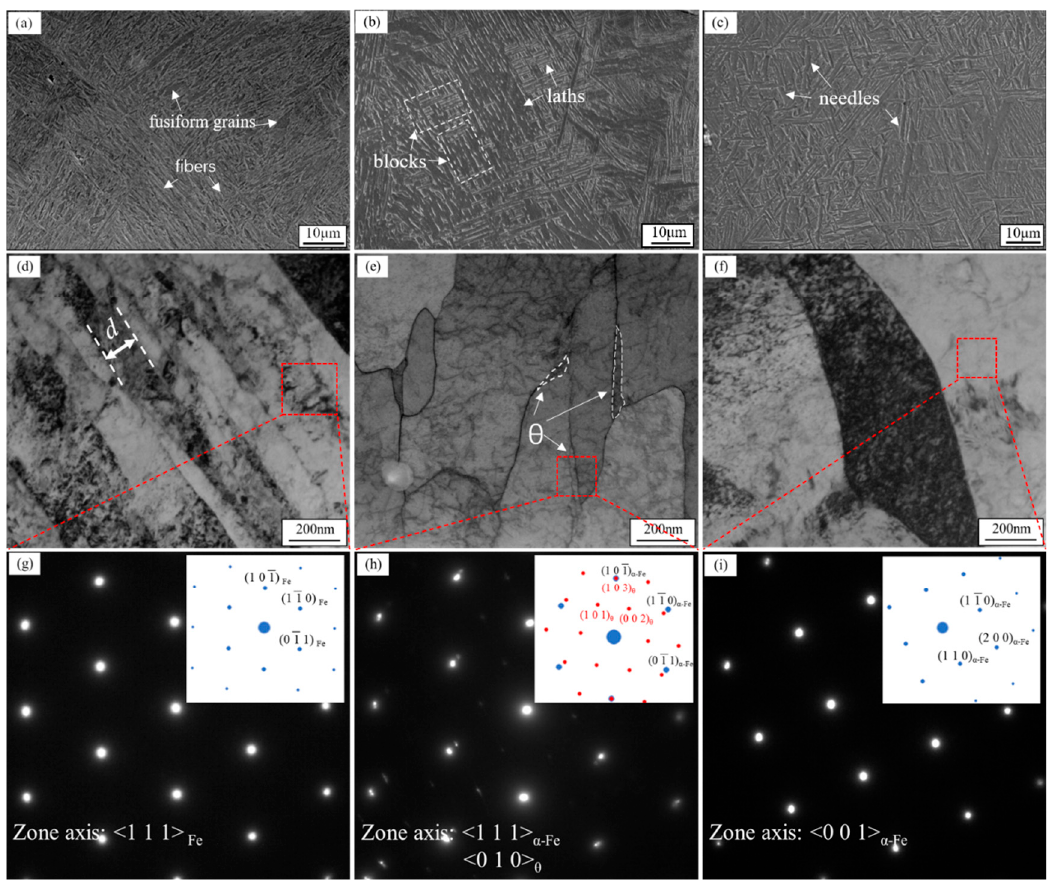
Figure 2. Microstructures found at 0–200 µ m depth of the sample surface. ( a ) SEM image of martensite. ( b ) SEM of upper bainite. ( c ) SEM of acicular ferrite. ( d ) TEM image of martensite with the width of laths indicated between white dashed lines. ( e ) TEM of upper bainite with cementite outlined in white dashed lines. ( f ) TEM of acicular ferrite. ( g ) SAED pattern of martensite with a zone axis of < 111 > . ( h ) SAED of upper bainite with a zone axis of < 111 > and cementite with a zone axis of < 010 > . ( i ) SAED of acicular ferrite with a zone axis of < 001 > .